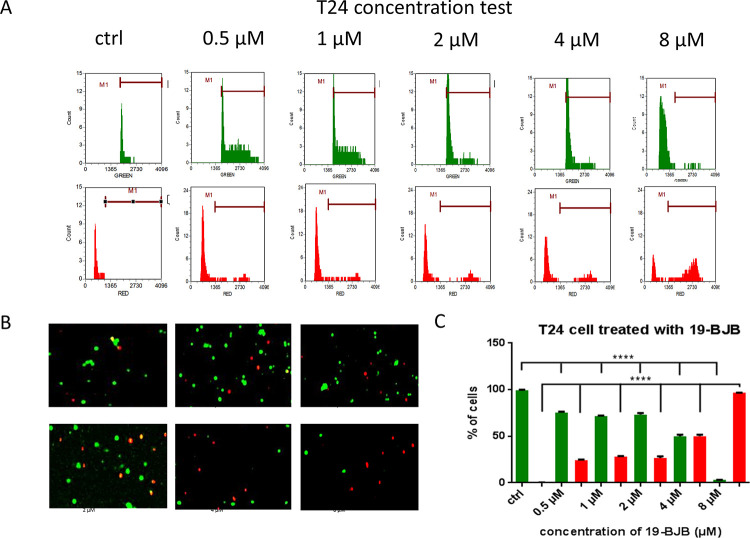
The results of live and dead test of cells detected by TailTM Image-Based Cytometer.Green column represented the number of live cells and red column represented the number of dead cells. (A) The raw data of fluorescence response of T24 cells after treated with different concentrations of 19-BJB for 48 h (0, 0.5, 1, 2, 4, 8 μM) was showed. (B) T24 live cells were stained green by 4 μM calcein AM and dead cells were stained red by 2 μM ethidium homodimer. The histogram data (C) of T24 are expressed as means ± SD from triplicate samples for each treatment. *p < 0.05, **p < 0.01, ***p < 0.001, ****p < 0.0001.